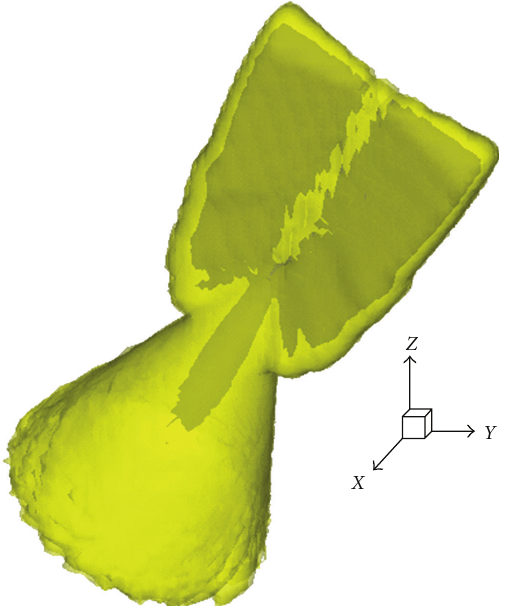
Figure 11: Iso-surface of single boron lance.